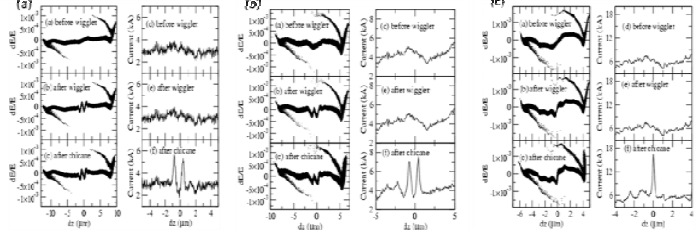
Fig. 2 The longitudinal energy distribution and c urrent profile wiggler and after chicane. (a) 3 kA, 20 µ m electron bunch . electron bunch,